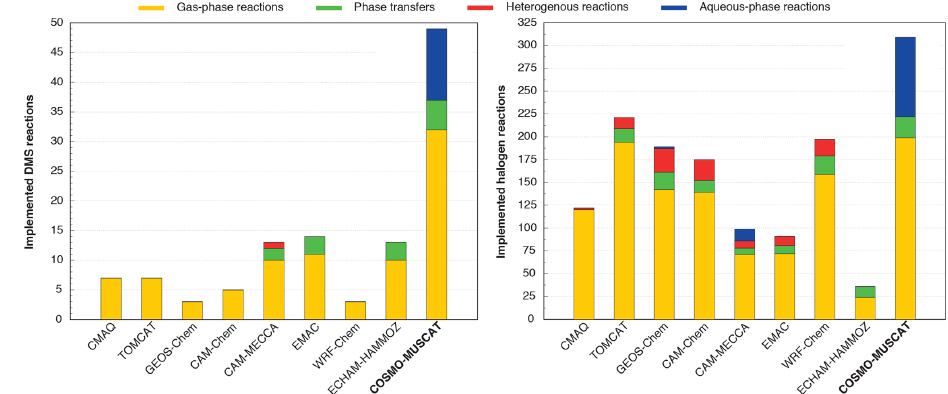
Figure 4. Comparison of applied tropospheric DMS and halogen chemistry mechanisms within the chemical transport models: CMAQ (Muniz-Unamunzaga et al., 2018), TOMCAT (Hossaini et al., 2016), GEOS-Chem (Wang et al., 2019), CAM-Chem (Saiz-Lopez et al., 2014), CAM-MECCA (Long et al., 2014), EMAC (Jöckel et al., 2016), and WRF-Chem (Badia et al., 2019). EMAC is a chemistry climate model that can be run as a